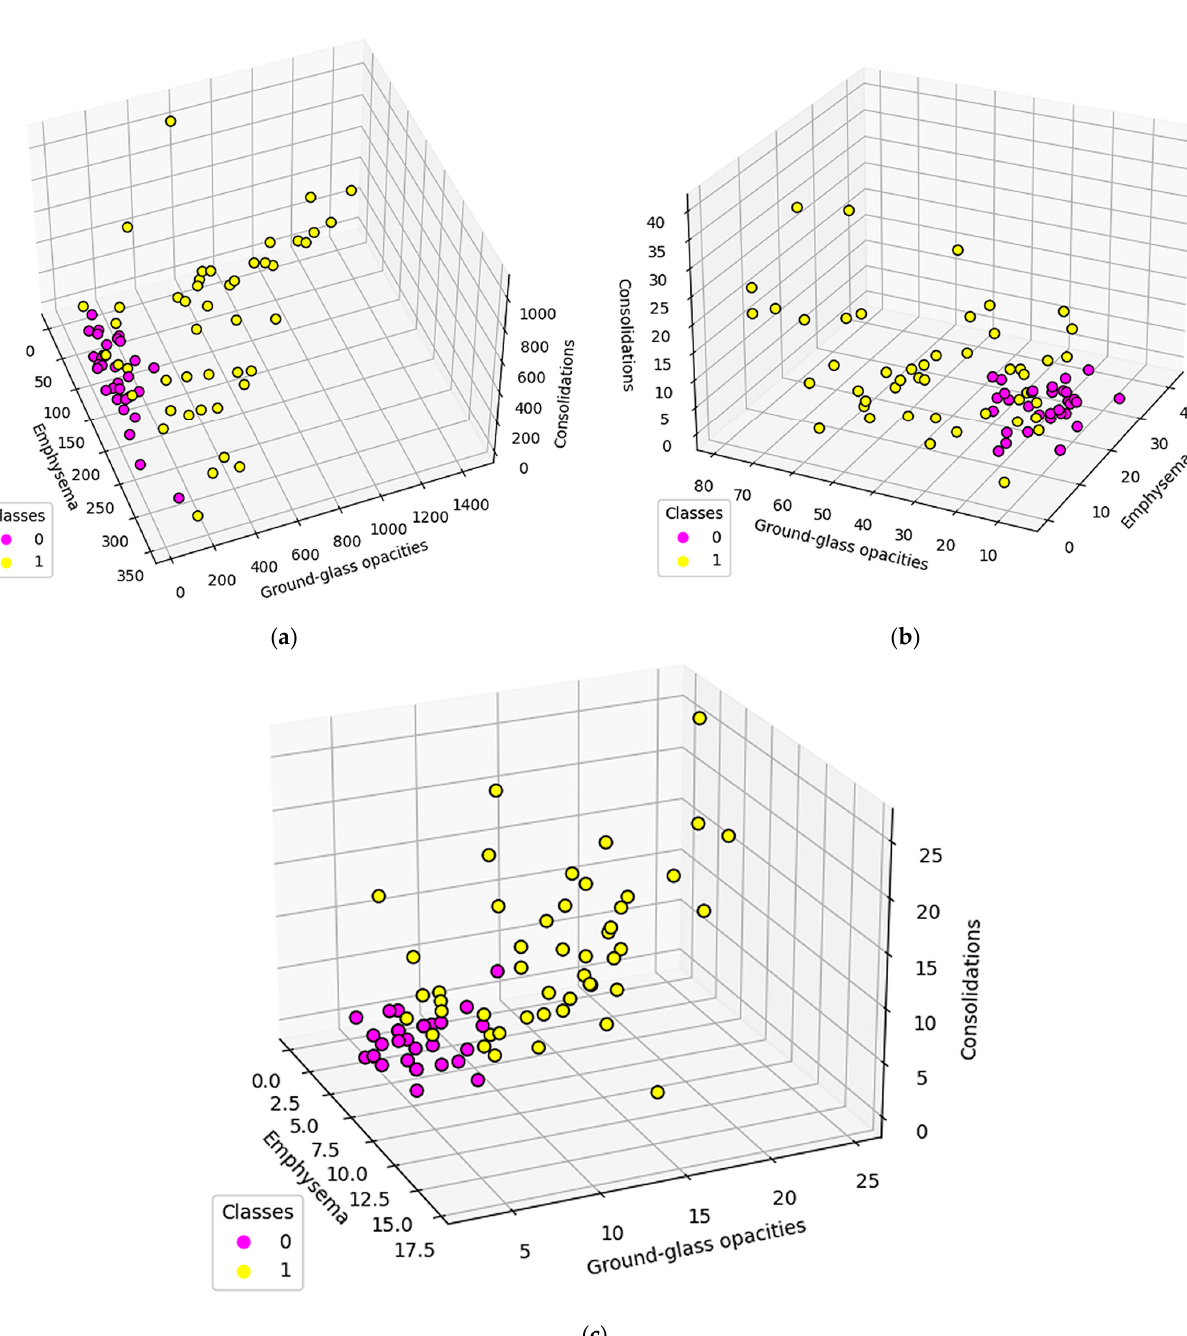
Figure 8. Population distribution comparisons according to specific complex network parameters: ( a ) Total count ( b ) Average count ( c ) Maximum degree Class 0 (fuchsia) represents normal lungs, while class 1 (yellow) is formed of DILD affected lungs.